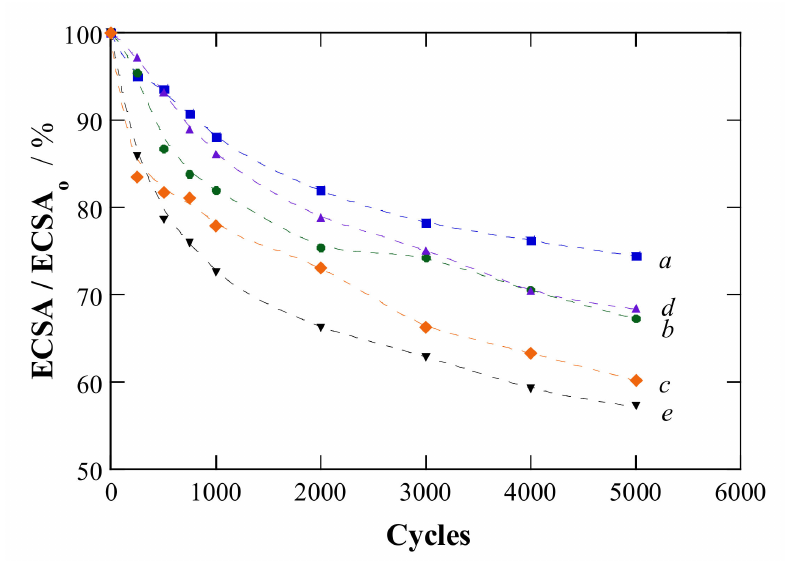
Figure 5. ECSA loss for each catalyst after cycling within the potential range between 0.6 and 1.0 V at 100 mV s − 1 in 0.5 mol dm − 3 H 2 SO 4 solution. Curves a – e correspond to the same catalysts indicated in Figures 3 and